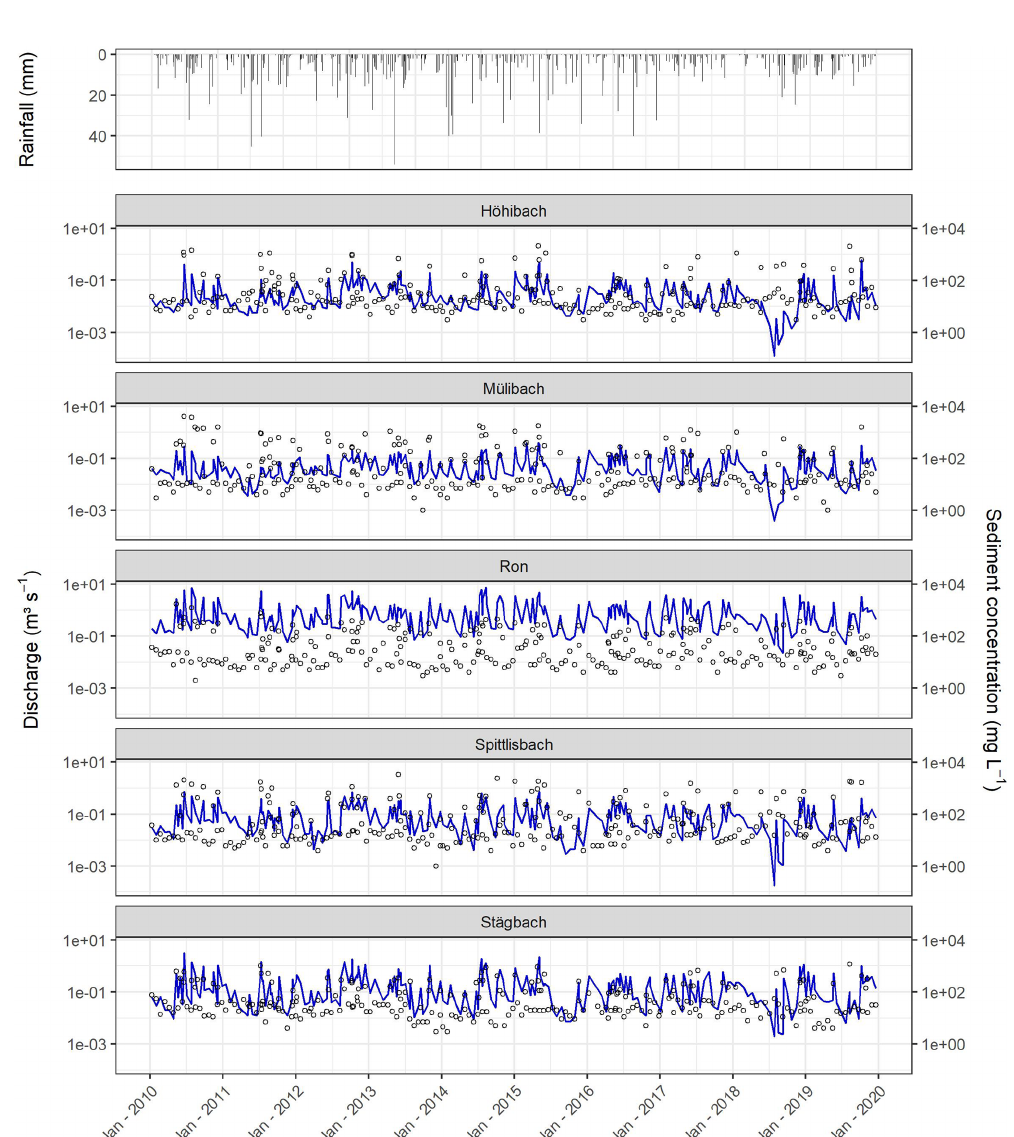
Figure 3. Daily rainfall at Mosen station, mean daily discharge (blue line), and sediment concentration (circles) at the monitored tributaries of the Lake Baldegg (2010–2019). Data source: MeteoSwiss